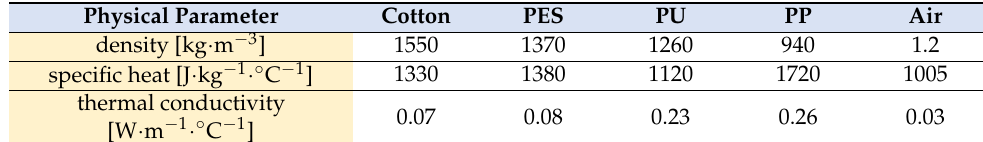
Table 3. Physical features of raw materials applied in simulations